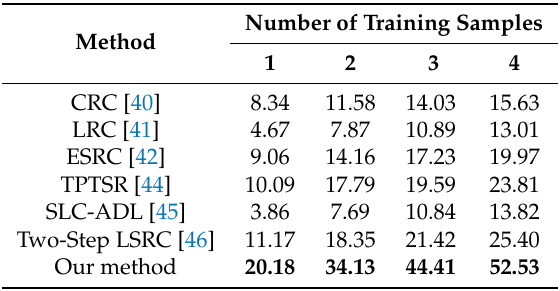
Table 6. Face recognition rates (%) of different methods on LFW database.